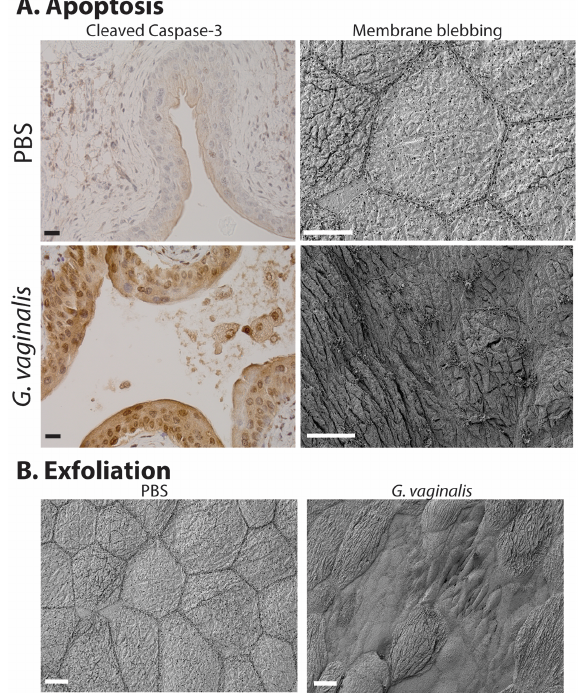
Figure 3: Gardnerella vaginalis induces apoptosis (A) and exfoliation (B) of the mouse bladder epithelium following two transurethral exposures, using our previously reported model